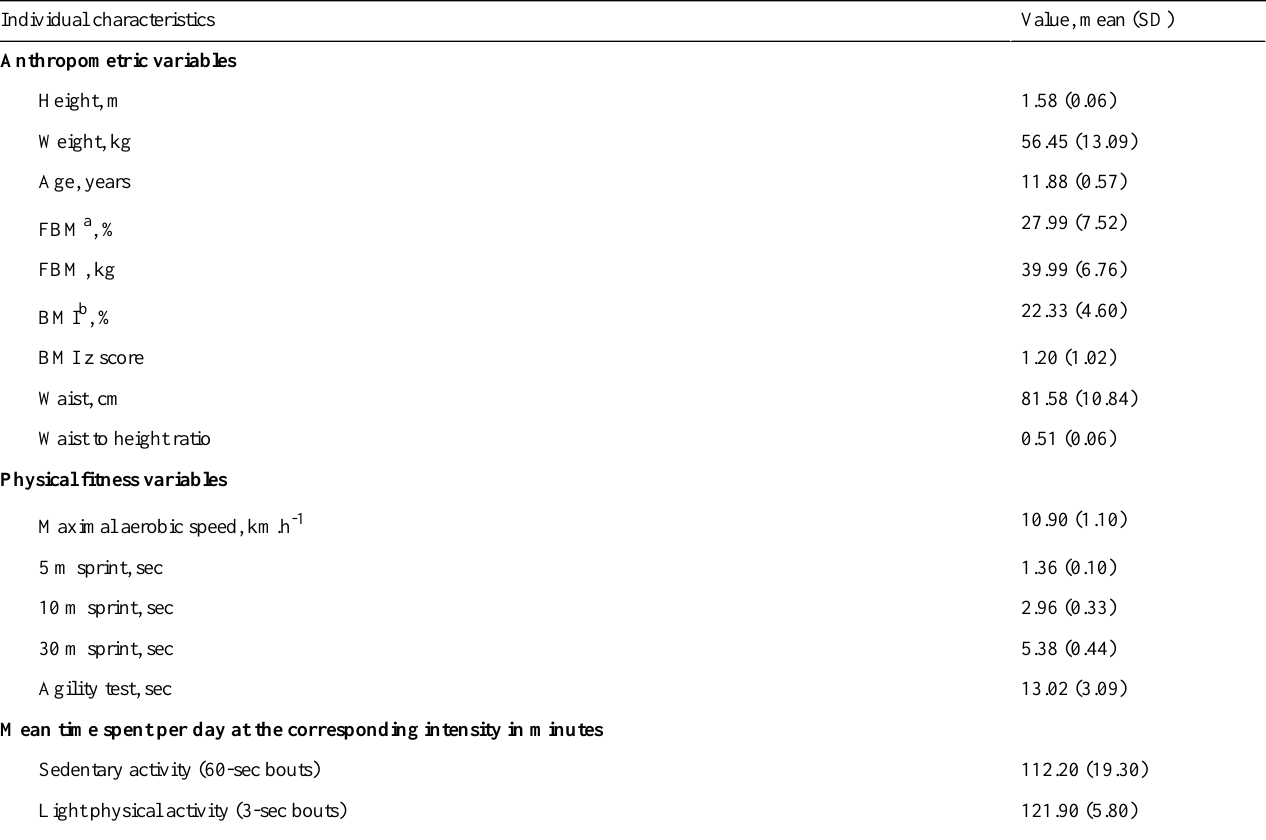
Table 1. Descriptive anthropometric, physical fitness, and physical activity data before the iEngage program (N=24).